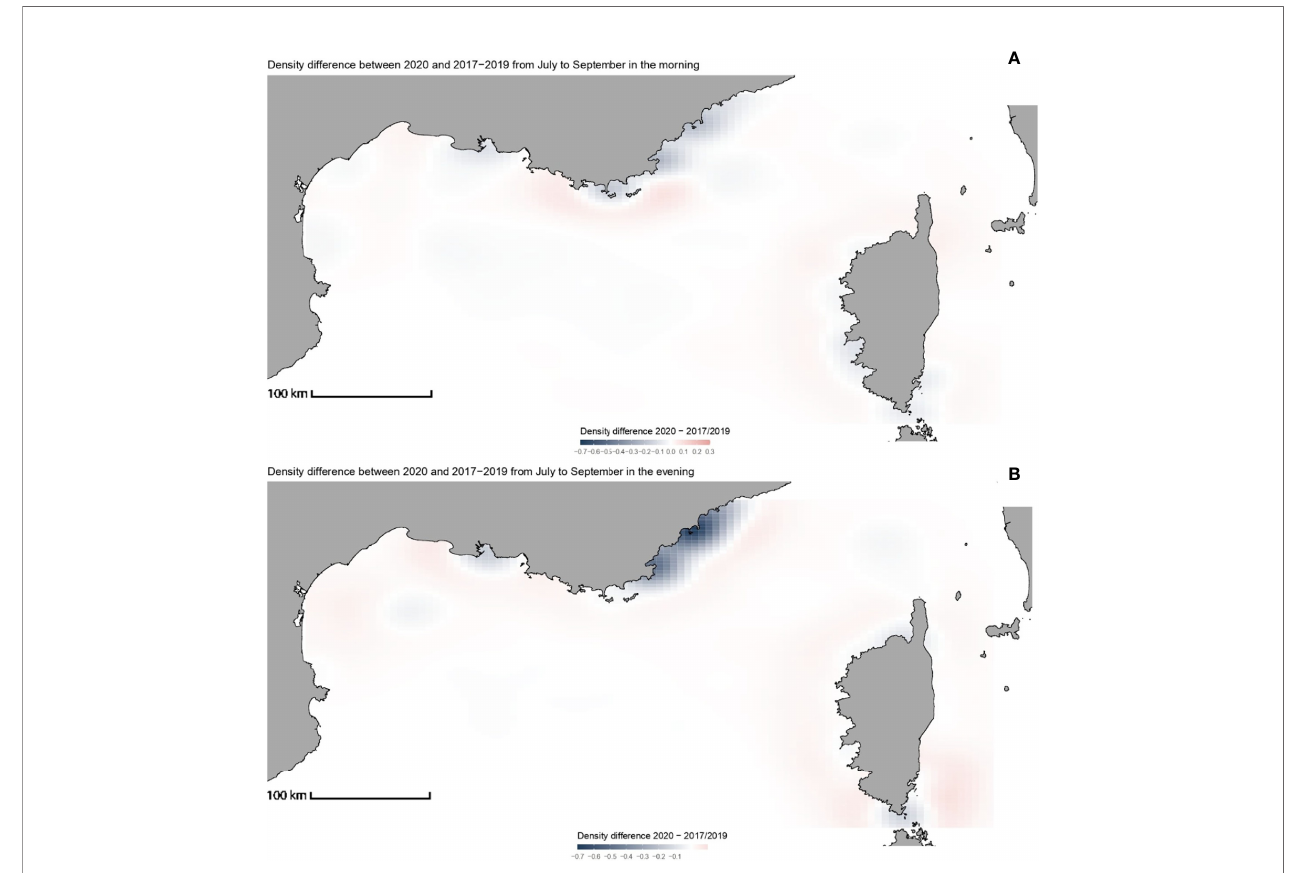
FIGURE 6 | Difference in Ship detection density between 2020 and the 2017-2019 period for the peak summer season for (A) morning 7:00 am to 8:00 am detections and (B) 7:00 pm to 7:45 pm